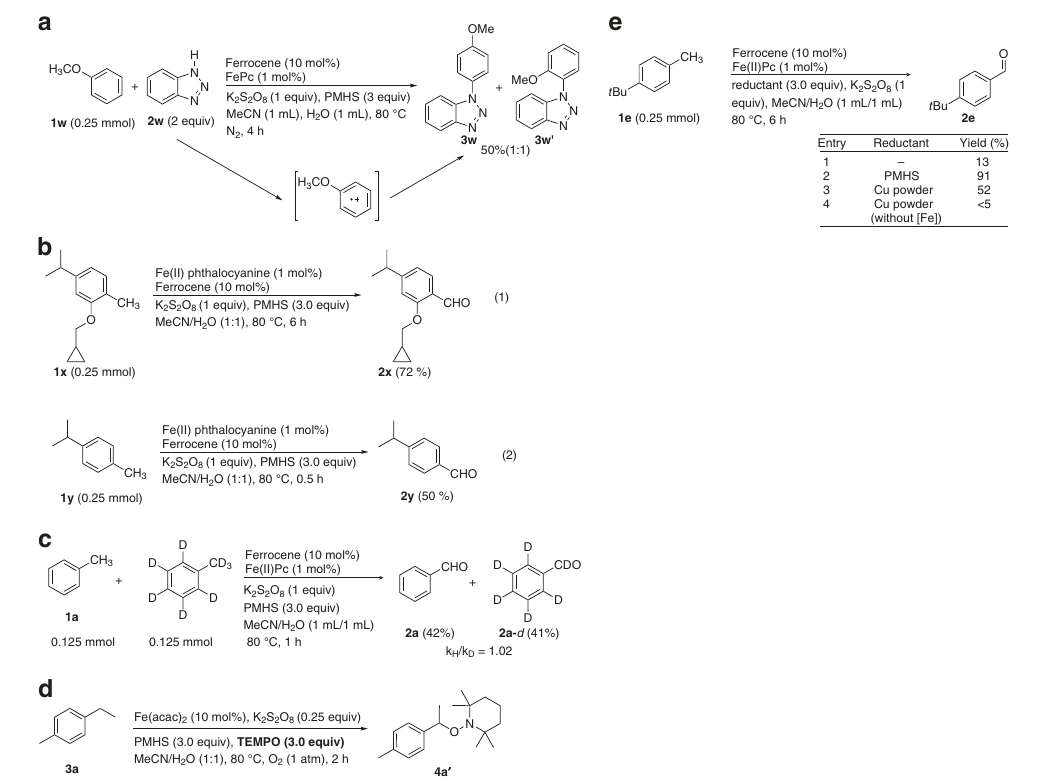
Fig. 6 Mechanistic experiments. a Probation for the presence of aromantic radical cation in the catalytic system. b Comparison of the reactivity between methyl and isopropyl groups in the catalytic system. c Intermolecular kinetic isotope effect. d Radical capture experiment. e Control experiments proving the reducing property of PMHS in the catalytic system